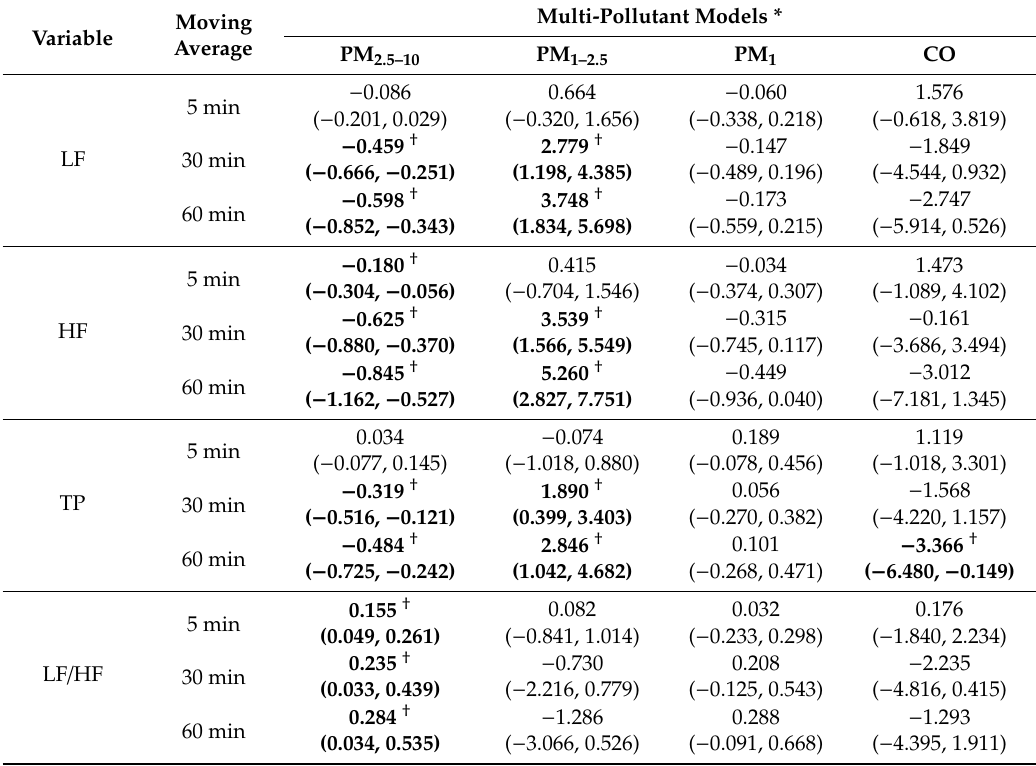
Table 4. Short-term exposure impacts on frequency domain HRV indices in multi-pollutant models.